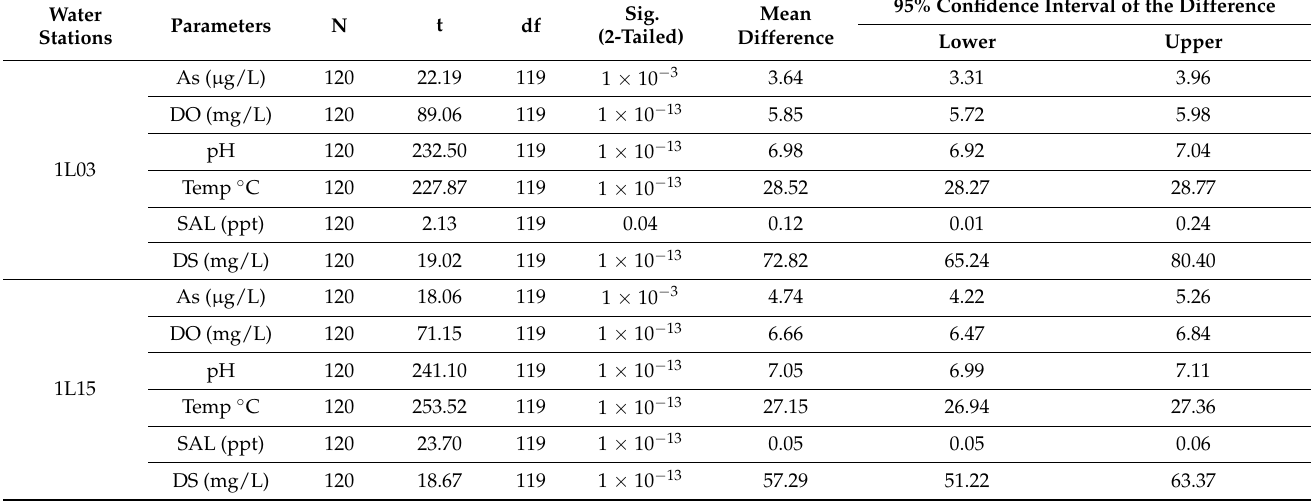
Table 2. One-sample t-test on monthly As ( μ g/L) concentrations and physico-chemical parameters at the water sampling stations in Langat River during 2005–2014.